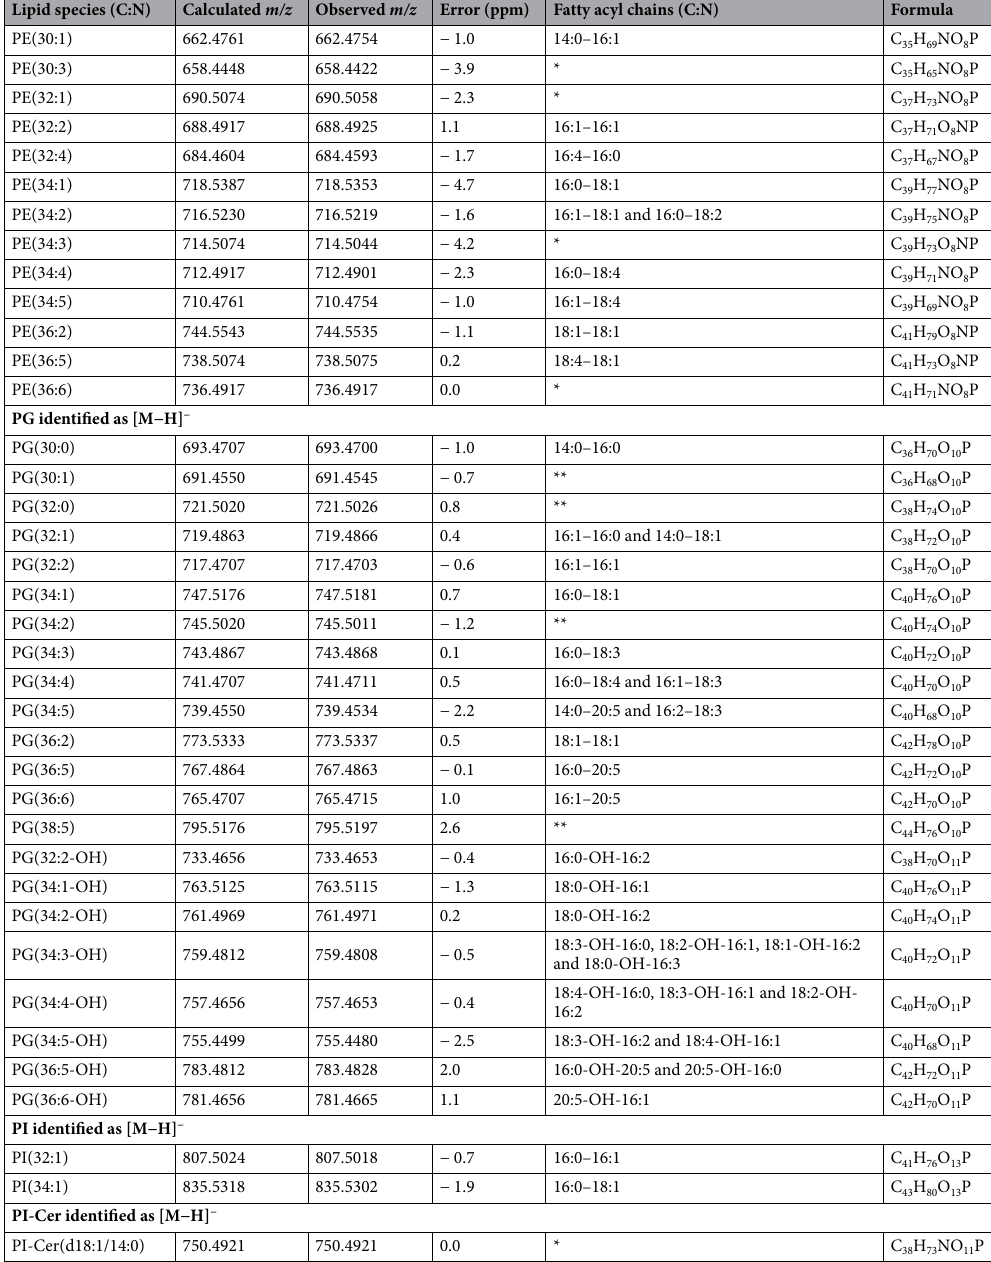
Table 3. Phospholipid species identified in the total lipid extract of Chlorococcum amblystomatis by HILIC– HR–ESI–MS and MS/MS. C number of carbon atoms, N number of double bonds. *Identified based on the polar head fragmentation, calculated mass, and retention time. **Identified according to the calculated mass and the retention